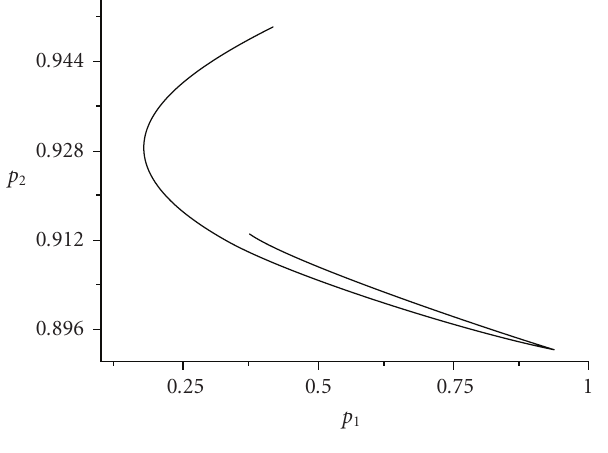
Figure 4.6 . Strange attractor for α 2 = 0 . 2.